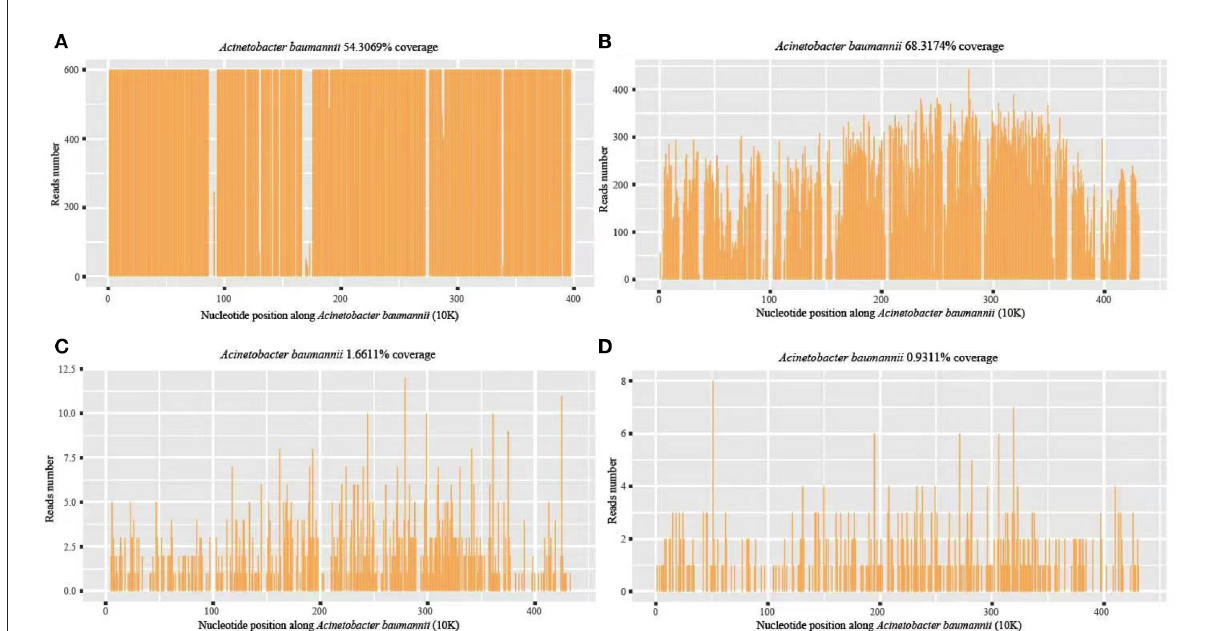
FIGURE3 A. baumannii coverage map of mNGS detection in different periods. (A) The first mNGS of CSF: 99,343 specific sequences of A. baumannii , with a coverage of 54.3%; (B) The second mNGS of CSF: 88,618 specific sequences and 68.32% coverage; (C, D) The third mNGS of CSF and blood: 857 (coverage 1.66%) and 446 (coverage 0.93%) specific reads,